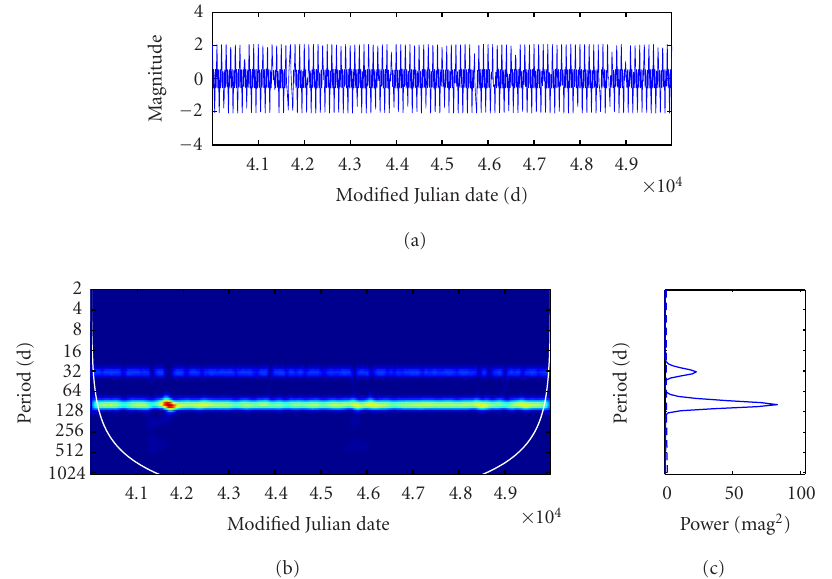
Figure 5: (a) Simulated signal built from the AC Herculis sampling (light curve). (b) Wavelet power spectrum. The continuous white line indicates the cone of influence. (c) Global wavelet spectrum of the simulated signal with a Morlet wavelet. The 95% confidence level that could be obtained for a white noise is shown by the dashed line.